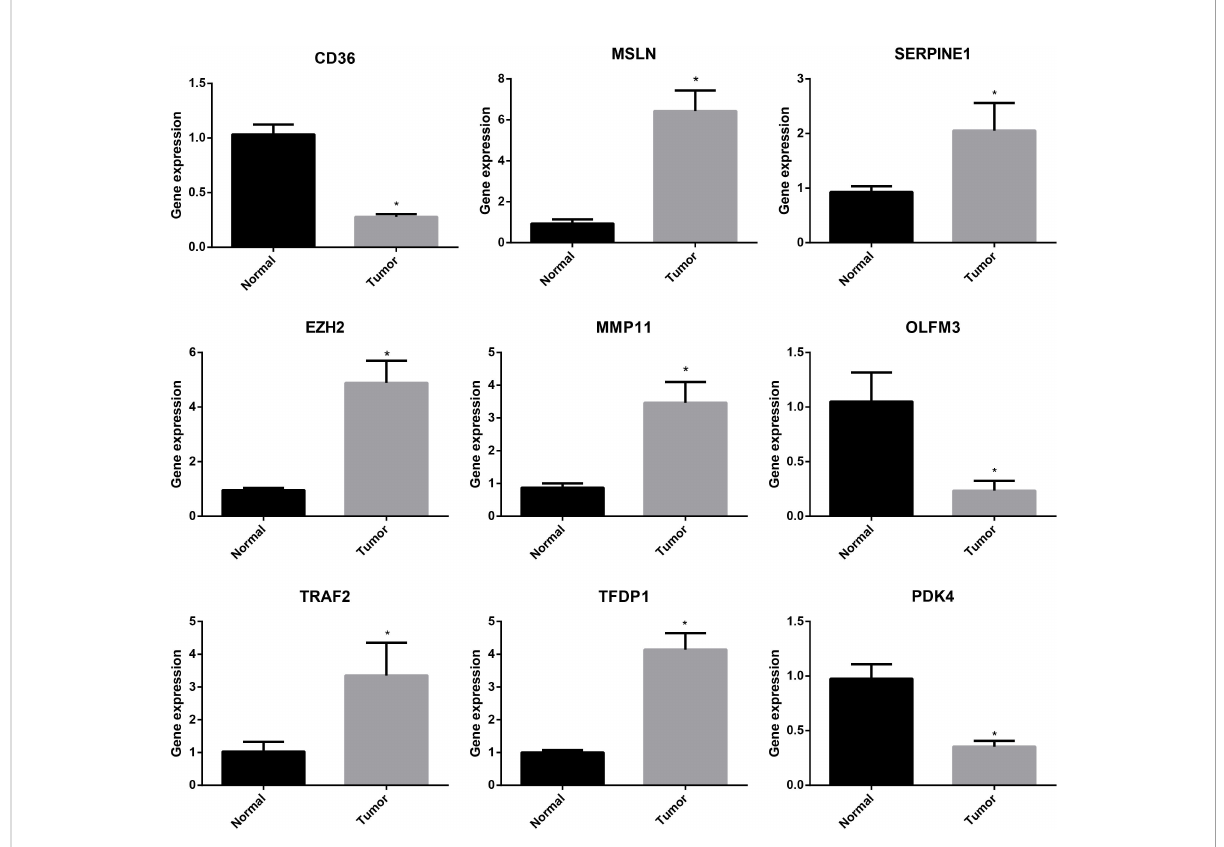
FIGURE 10 RT-PCR analysis of the genes of the ARGs signature. *P <